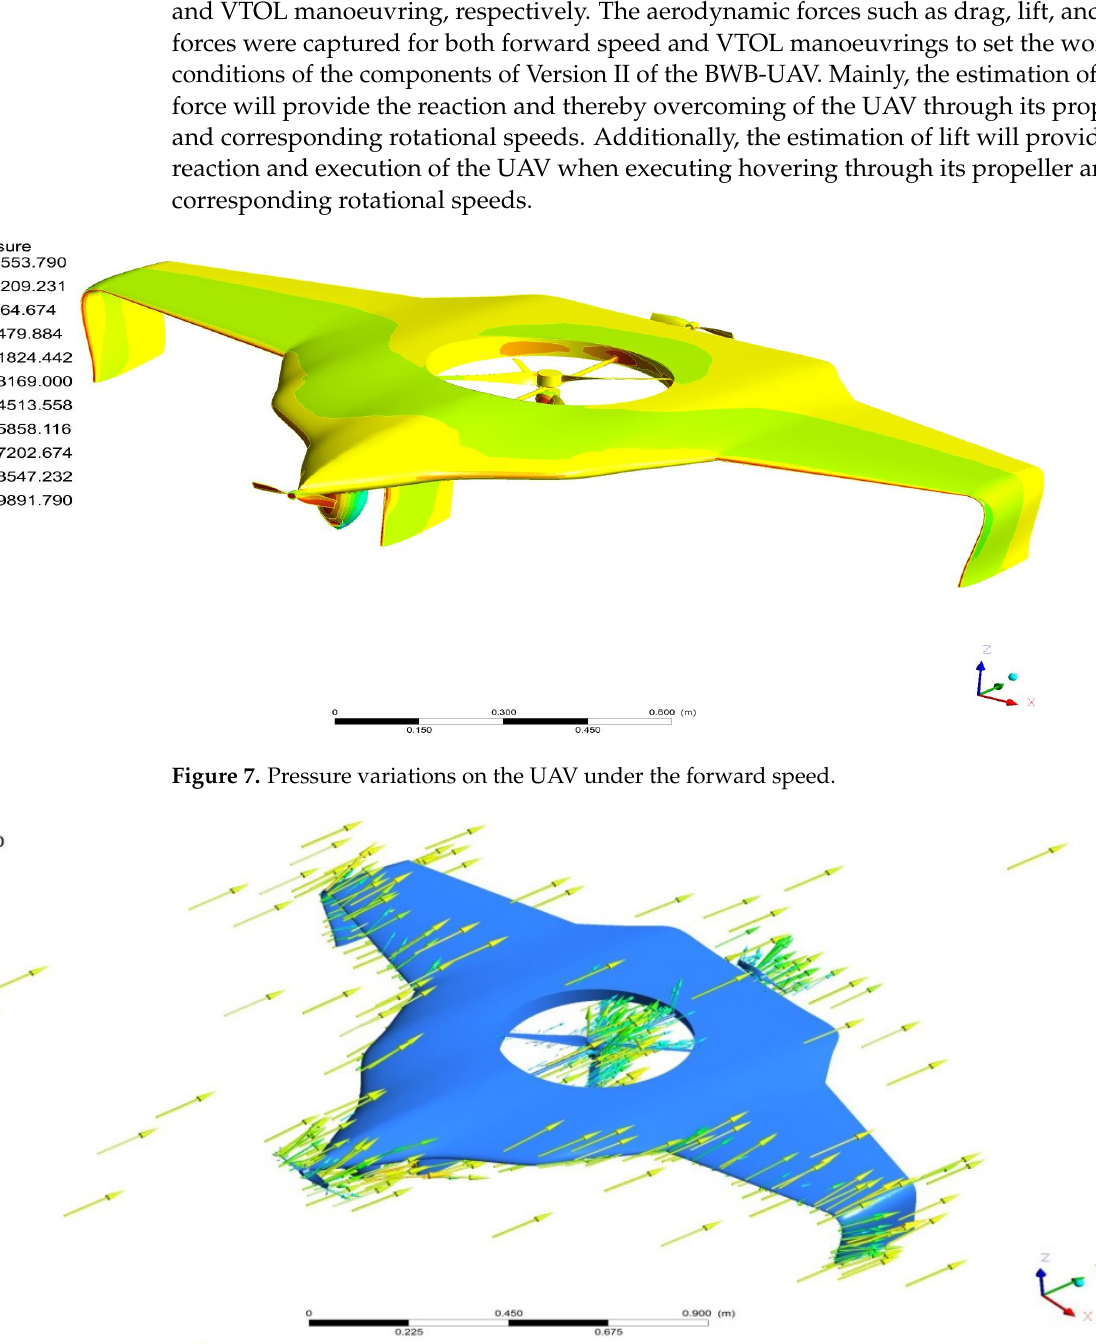
Figure 8. Velocity distributions over the UAV under the forward speed.